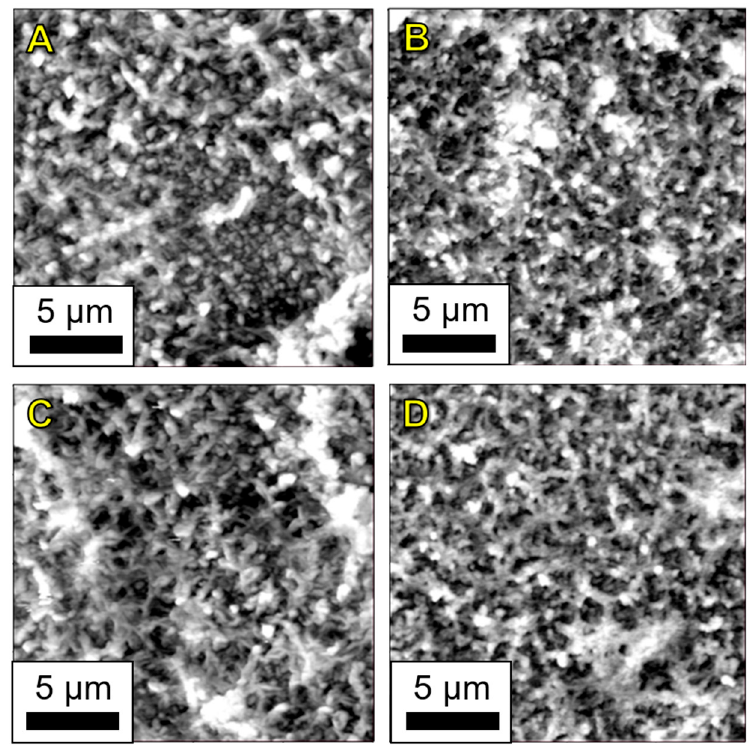
Figure 9. AFM height retrace scans of ( A ) plain polyamide, ( B ) 0.75 mg TOCN, vacuum filtration method, ( C ) 0.5 wt% TOCN, dispersion method, and ( D ) 0.5 wt% CNC dispersion method.